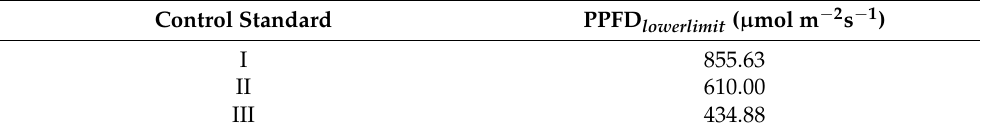
Table 3. Lower limits of PPFD corresponding to the three control